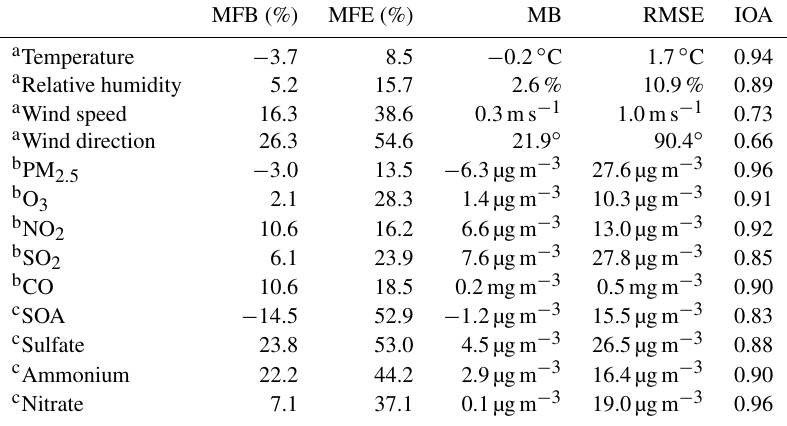
Table 2. Statistics for model